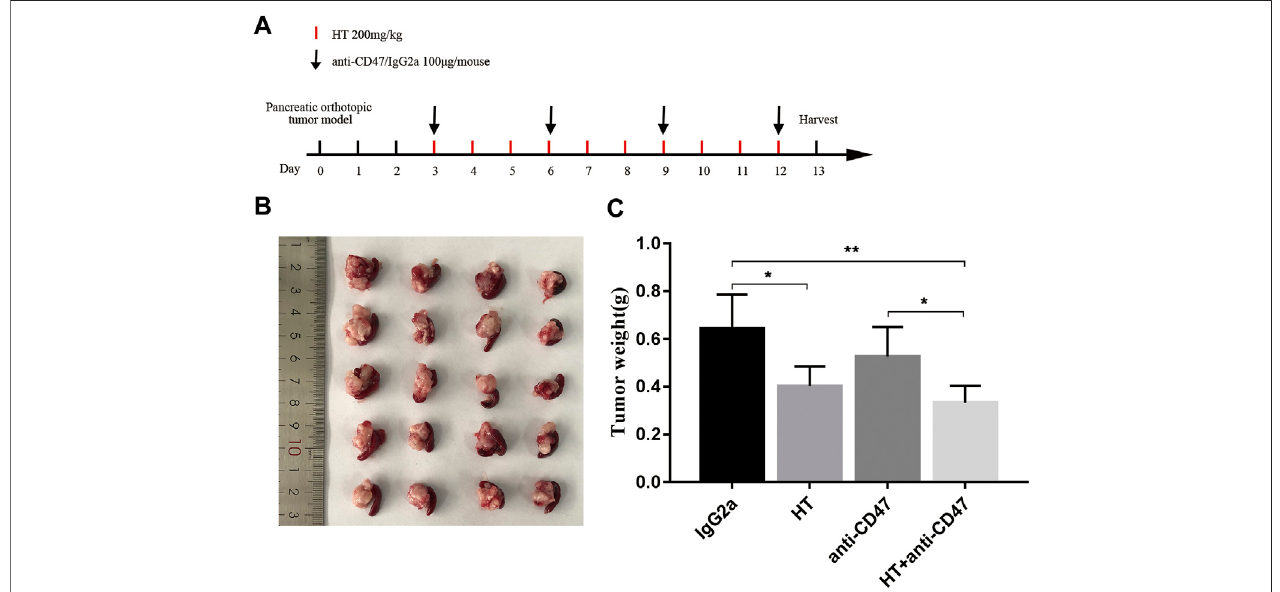
FIGURE 6 | HT enhances the anti-tumor effect of anti-CD47 antibody. Tumor-bearing mice received the treatment schedule shown in (A) . The tumors after treatment in each group ( n (cid:2) 5) were separated and compared (B,C) (* p < 0.05, ** p < 0.01).